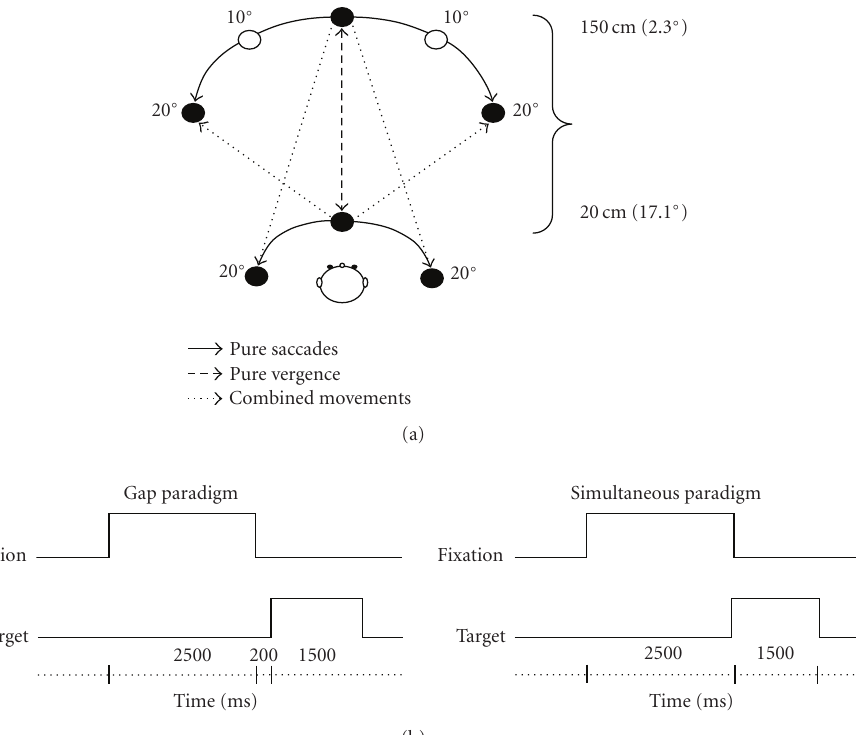
Figure 1: Spatial arrangement (a): LEDs were placed on an horizontal table at eye level. Three types of eye movements were elicited depending on the combination of the fixation and target LEDs: pure saccades far or close, pure vergence along the median axis, and combined movements; Temporal arrangement (b); schematic diagram of the temporal arrangement used in the two di ff erent paradigms (gap and